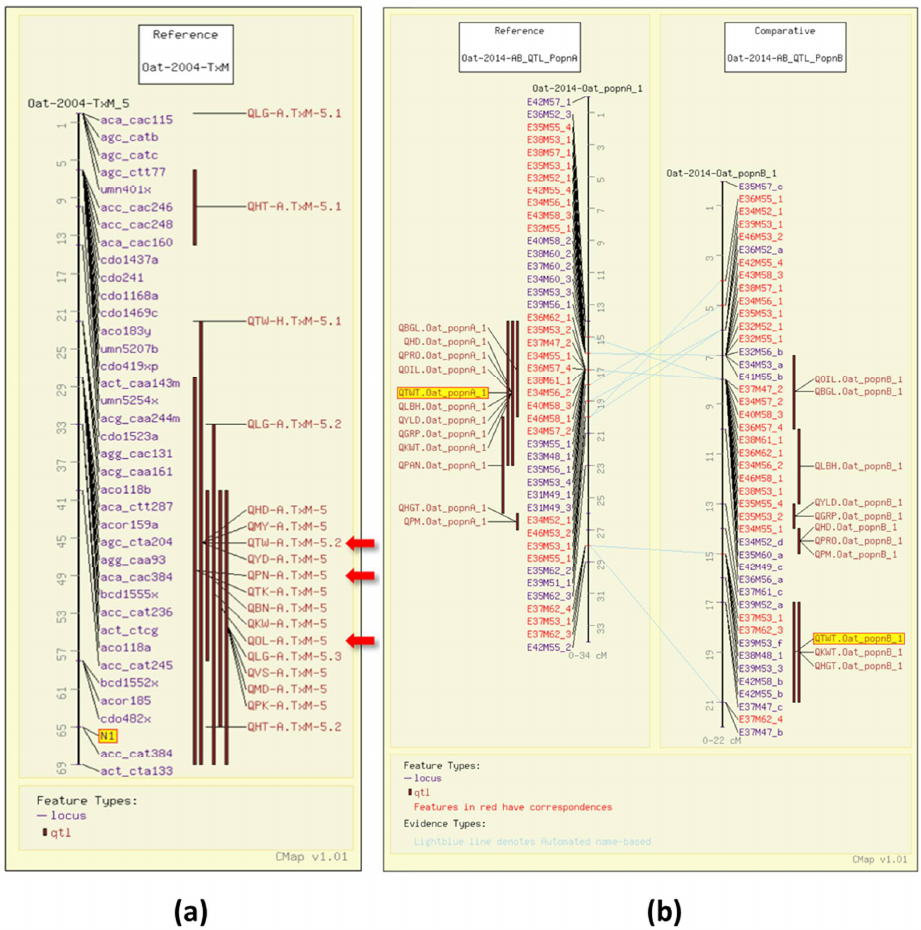
Figure 2. Test weight (TWT) QTL illustrated on the CMap map viewing/comparative mapping tool. ( a ) Several QTL for quality and agronomic traits overlapping with the N1 locus (highlighted) for the covered/hulless trait on the Terra x Marion population. QTL also discussed below are highlighted with red arrows, these include QTW-A.TxM-5.2 for test weight, QPN-A.TxM-5 for protein content, and QOL-A.TxM-5 for groat oil content.; ( b ) Alignment of linkage groups from two advanced backcross Iltis populations illustrating overlapping QTL within populations including test weight QTL (highlighted). Note the QTL map to the same linkage groups, as determined by the number of common markers, but map to different